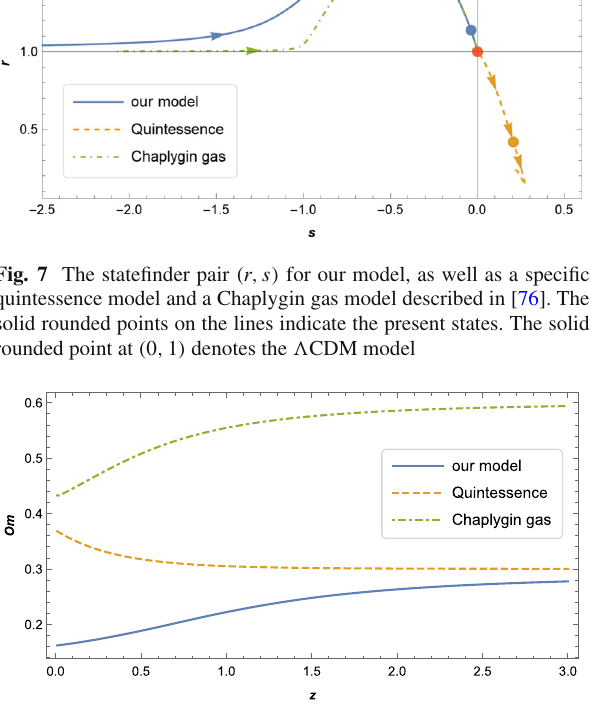
Fig. 8 Om - z diagram for our model, as well as a specific quintessence model and a Chaplygin gas model described in [76] for